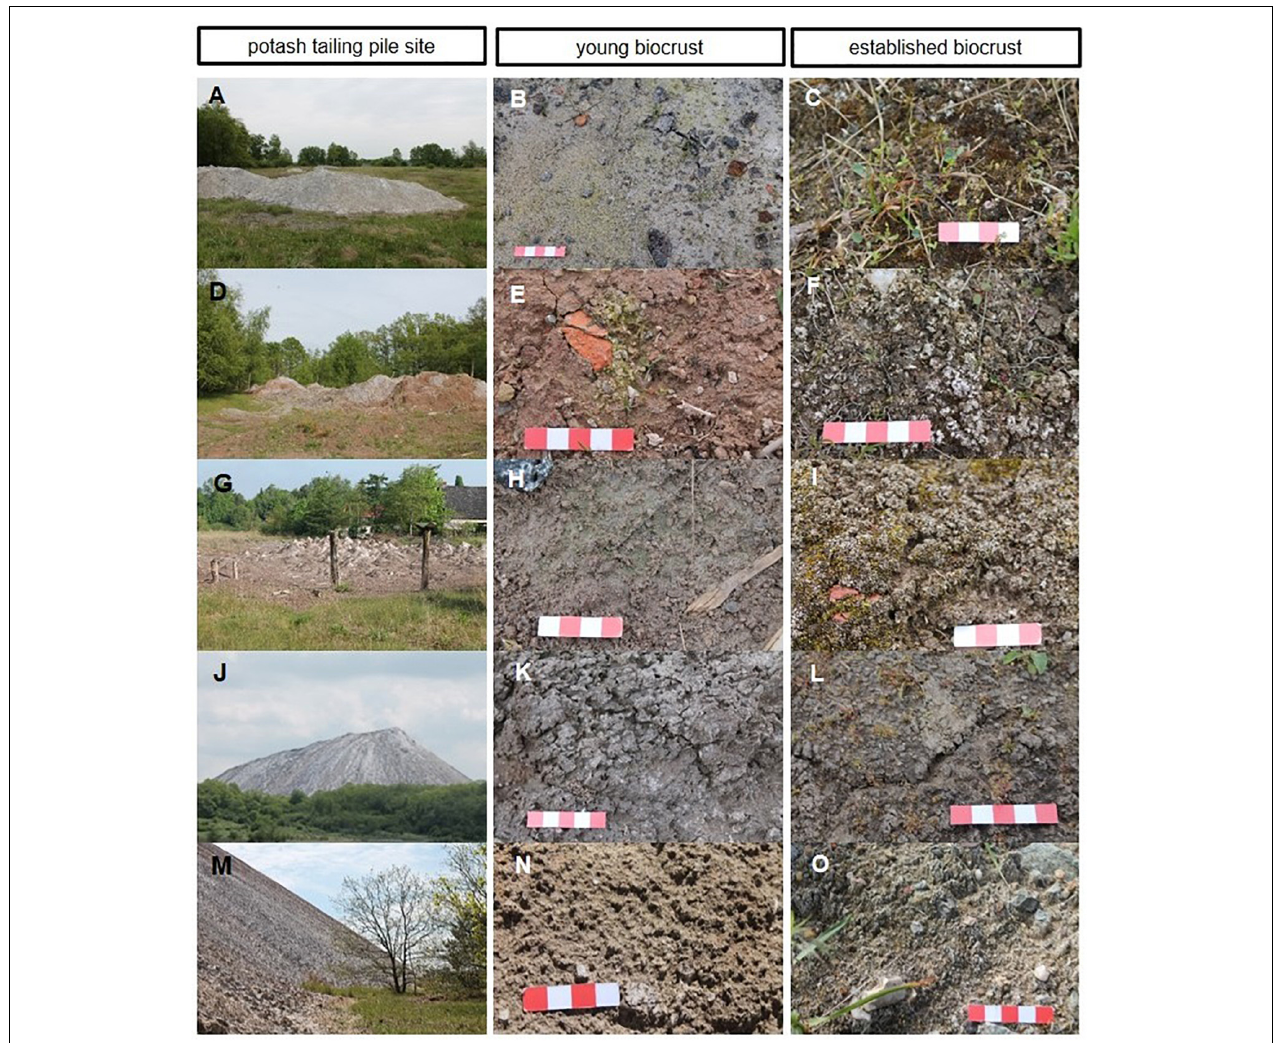
FIGURE 2 | Potash tailings piles sites and the respective young and established terrestrial algal communities. (A–C) Shreyahn; (D–F) Oedesse; (G–I) Wietze; (J–L) Teutschenthal; (M–O) NN; one red or white square of the scale bar indicates 1